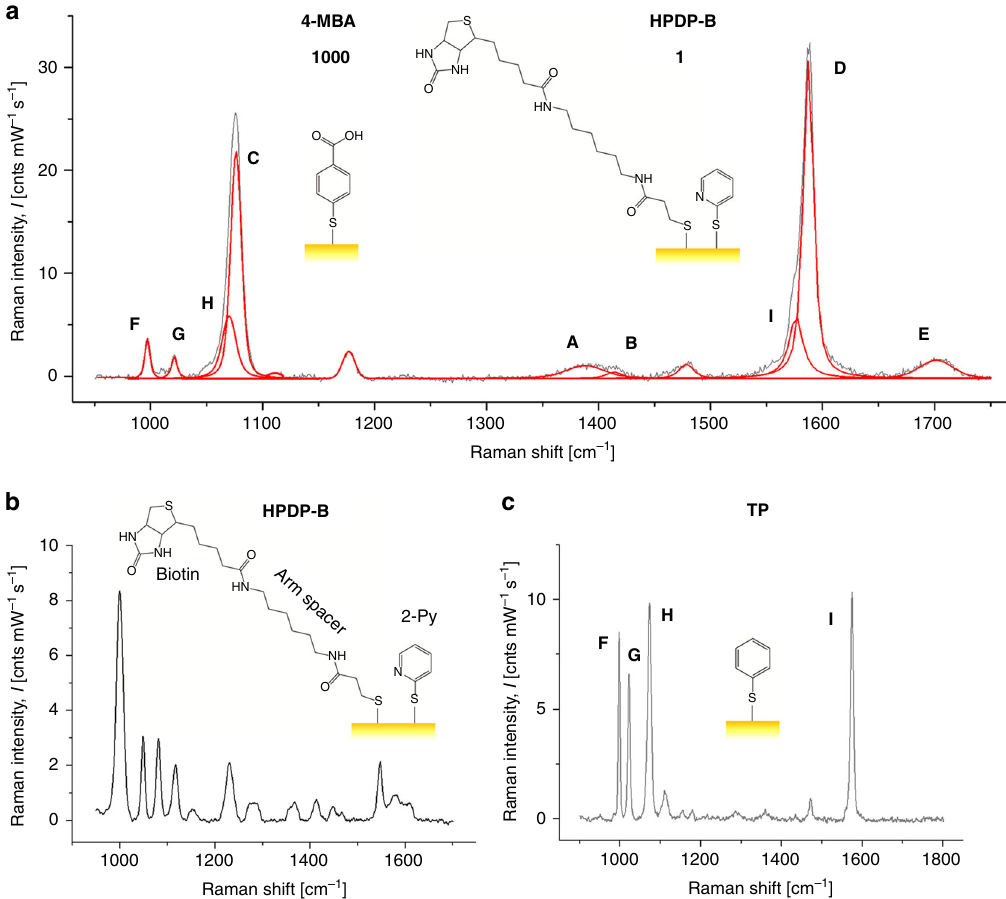
Fig. 5 Interpretation of the SERS intensity bands collected from the pH nanosensor. Representative SERS spectra of a 4-MBA/HPDP-B (ratio 1000/1), b HPDP-B, and c thiophenol (TP) conjugated AuNP. In b and c the HPDP-B and TP concentrations were equal to the concentration of 4-MBA used in a . In a the bands of the spectrum were fi tted using Voigtian functions and the assignments of 4-MBA and TP vibration modes, which enabled mathematical deconvolution of the intensities of bands A + B, C + H and D +